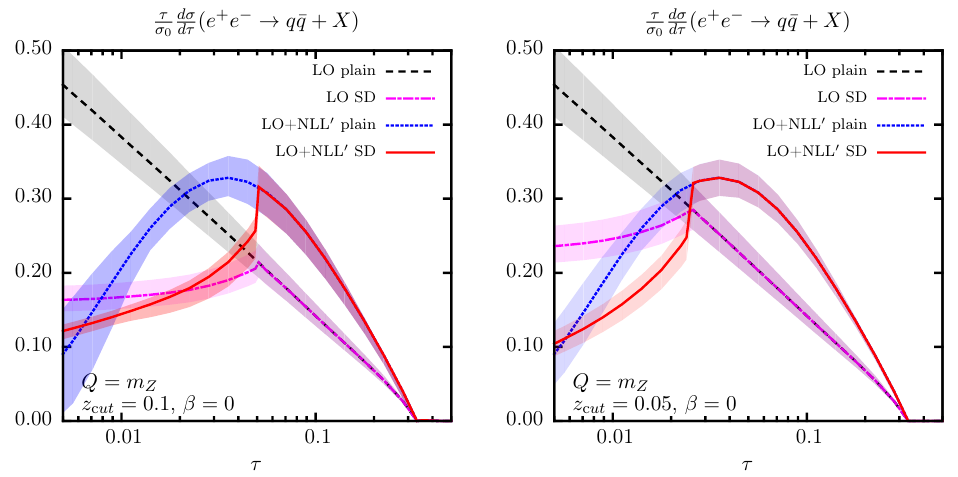
Figure 6 . The results for the (cid:12)xed order and resummed di(cid:11)erential cross section of the plain and soft-dropped thrust for e + e (cid:0) collisions at a centre of mass energy Q = m Z and the soft drop parameters (cid:12) = 0 and z cut = 0 : 1 (left) and z cut = 0 : 05 (right). The (cid:12)gure shows LO for plain thrust (black dashed) and soft-dropped thrust (magenta dashed-dotted) and the matched LO+NLL 0 cross section for plain thrust (blue dotted) and soft-dropped thrust (red solid) with the bands from resummation and scale uncertainties included.